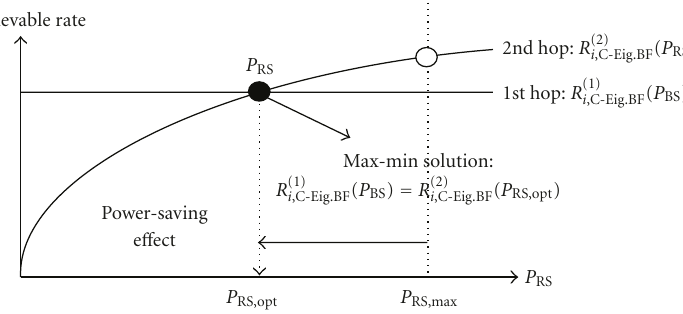
Figure 5: Design concept of the proposed power allocation